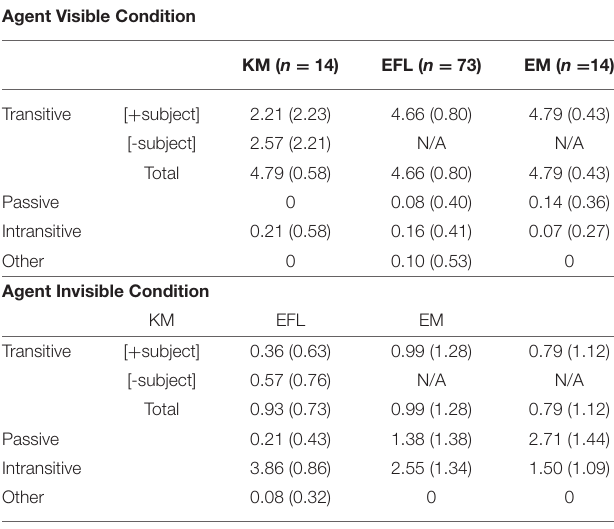
TABLE 3 | Descriptive statistics: group means (and standard deviations). Agent Visible